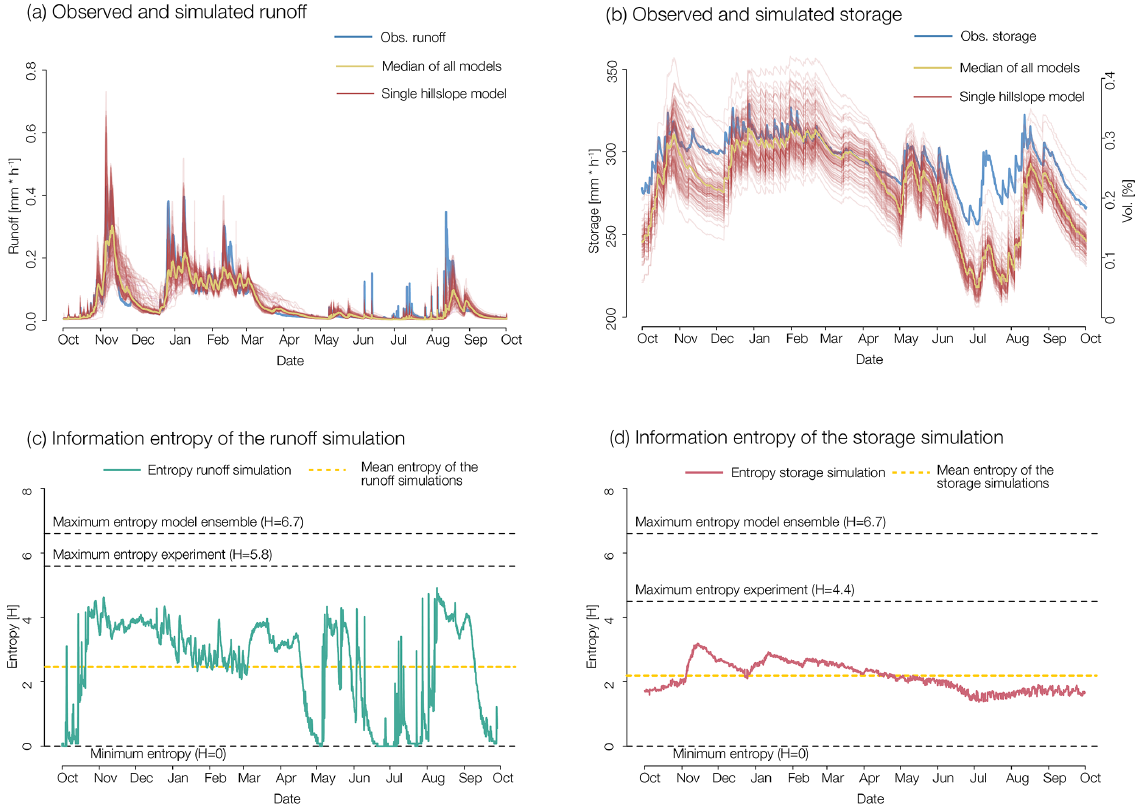
Figure 4. (a) Observed and simulated runoff of the Colpach catchment. The red lines correspond to individual hillslope models and the yellow line to the area-weighted median of all hillslopes. (b) Simulated total area specific storage of each hillslope in red and the median of all models in yellow. The median of the 141 observed soil moisture time series is smoothed with a 12h rolling mean (for more detail to the soil moisture observation we refer to Loritz et al., 2017). (c) Shannon entropy in turquoise for the runoff simulations as well as the corresponding mean and (d) a similar plot for the storage simulations